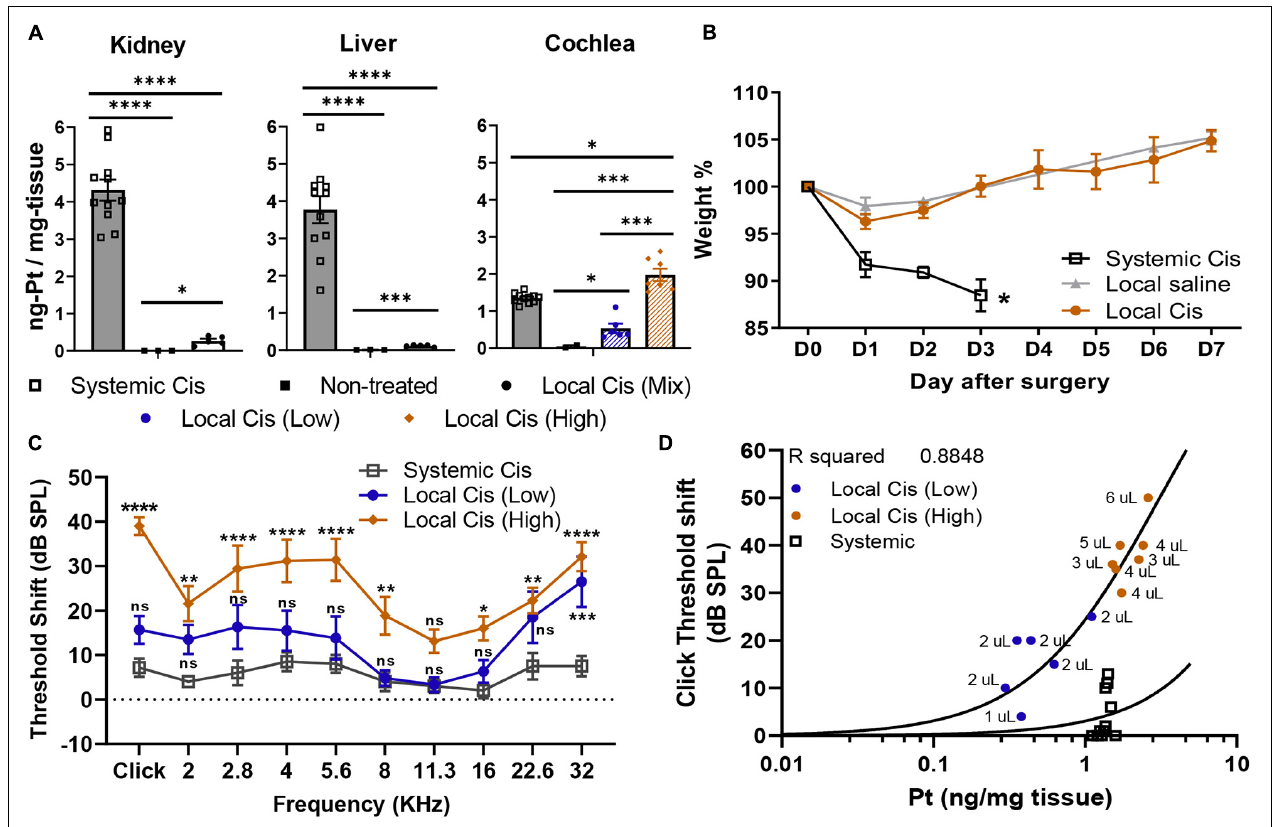
FIGURE 5 | Comparison of systemic vs . local cisplatin delivery. (A) Comparison of platinum concentration (ng-Pt/mg-tissue) ( n = 26) in kidney, liver, and cochlea of control (non-injected), IP (10 mg/kg) cisplatin-injected, and cisplatin (5 mM) trans bulla-delivered mice. Mice delivered with cisplatin retroauricularly were divided into two groups according to volume delivered. Group receiving ≥ 3 µ l of cisplatin solution is denominated as “high” cisplatin (orange), and group receiving < 3 µ l is “low” cisplatin (blue). (B) Posttreatment weight evolution. Systemic delivery of 10 mg/kg cisplatin led to weight loss > 10% and early sacrifice at D3, whereas local delivery only mildly affected weight ( < 5%) in first 2 days post-intervention. Presurgery weight (D0) was set as 100%. (C) Local delivery permanent threshold shift dataset (from Figure 1 ), as calculated from unilateral auditory brainstem response (ABR), in “high” (orange) and “low” (blue) volume cisplatin-treated animals ( n = 13), is reused for comparison with hearing threshold shifts of animals receiving systemic cisplatin delivery (10 mg/kg). (D) Correlation plot between click-evoked hearing threshold shifts and Pt titer 7 days after local cisplatin delivery [5-mM cisplatin ( n = 13)] and 3 days after systemic delivery (IP 10 mg/kg). Associated to each dot, bulla volume value is displayed (microliters). The confidence interval for both statistics was set as 95% ( a = 0.05); ∗ p < 0.05; ∗∗ p < 0.01; ∗∗∗ p < 0.005; ∗∗∗∗ p <